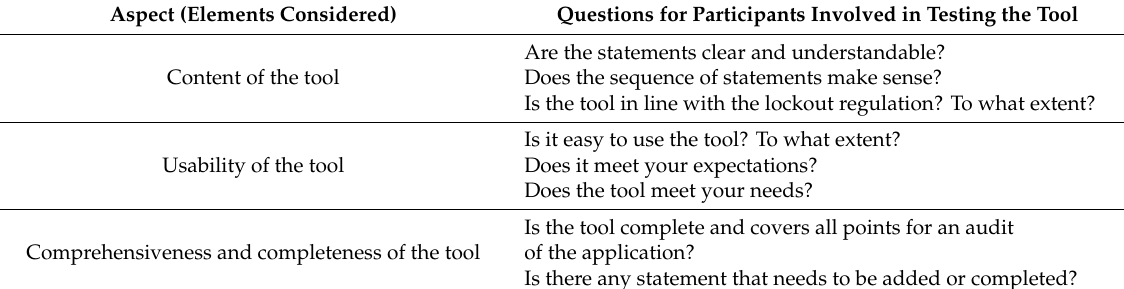
Table 2. Questions used for testing content validity.